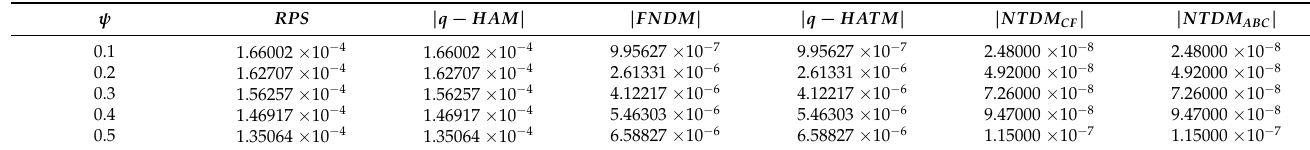
Table 2. Error comparison among RPS , q − HAM , FNDM , q − HATM , NDM CF and NDM ABC for problem 1 at β = 1.